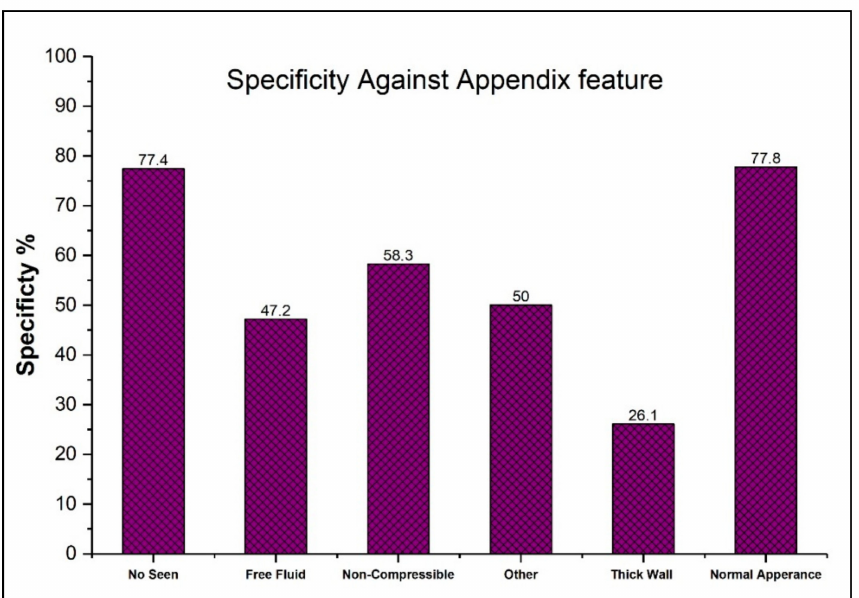
Figure 2. Specificity readings against image features.